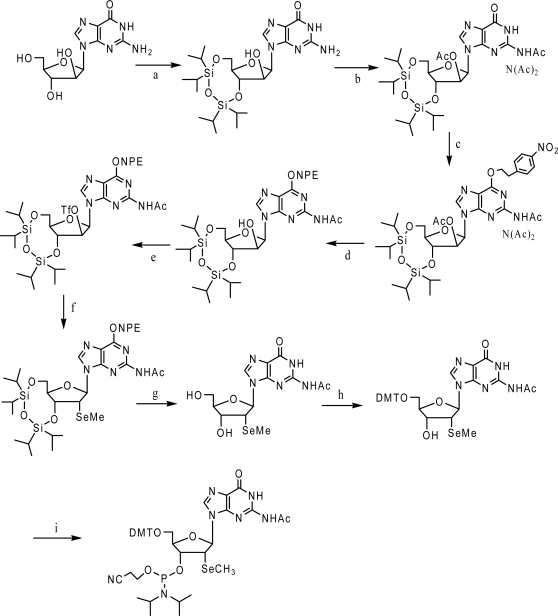
Synthesis of the 2’-methylseleno guanosine phosphoramidite. (a) 1.05 equiv of TIPDSiCl2, in DMF/pyridine, room temperature, 16 h, 98% (b) 10 equiv. of acetic anhydride, in DMF/pyridine, 80 °C, 16 h, 64% (c) 1.3 equiv. of NPE-OH, 1.4 equiv. of PPh3, 1.3 equiv. of DIAD, in dioxane, room temperature, 3 h, 64% (d) aqueous ammonium hydroxide in THF/methanol/water, 0 °C, 5 min, 57% (e) 1.5 equiv. of trifluoromethanesulfonyl chloride, 1.5 equiv. of DMAP, 2.5 equiv. of NEt3, in CH2Cl2, 0 °C, 2 h, 69% (f) 6 equiv. of NaBH4, 2 equiv. of CH3SeSeCH3, in THF, 20 min, 87% (g) 1 M TBAF, in THF, room temperature, 2.5 h, 79% (h) 1.1 equiv. of DMT-Cl, in pyridine, room temperature, 16 h, 59% (i) 1.5 equiv. of (2-cyanoethyl)-N,N-diisopropylchlorophosphoramidite, 10 equiv of CH3CH2N(CH3)2, in CH2Cl2, room temperature, 2 h, 88% (DIAD diisopropyl azodicarboxylate, DMAP 4-(dimethylamino)-pyridine, DMT dimethoxytrityl, NPE 2-(4-nitrophenyl)ethyl, TBAF tetrabutylammonium fluoride, TIPDSiCl2 1,3-dichloro-1,1,3,3-tetraisopropyldisiloxane).